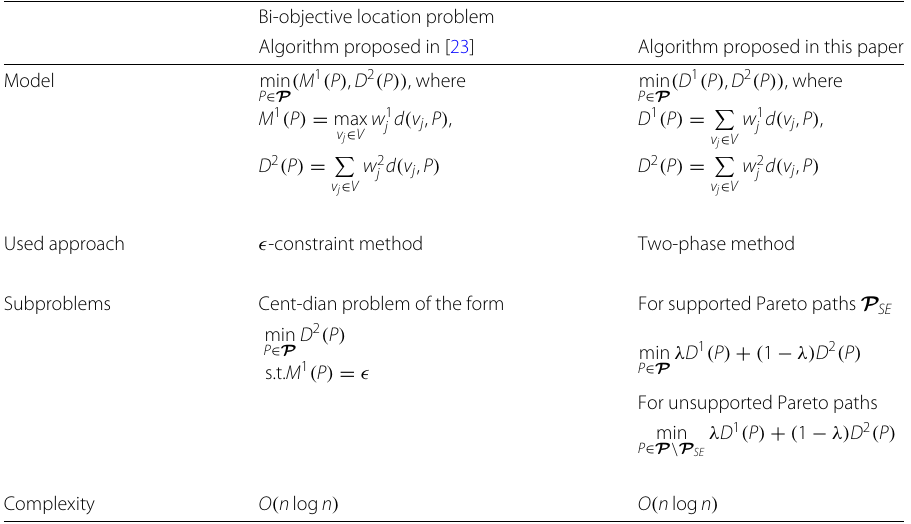
Table 1 Summary of results Bi-objective location problem Algorithm proposed in [23] Algorithm proposed in this